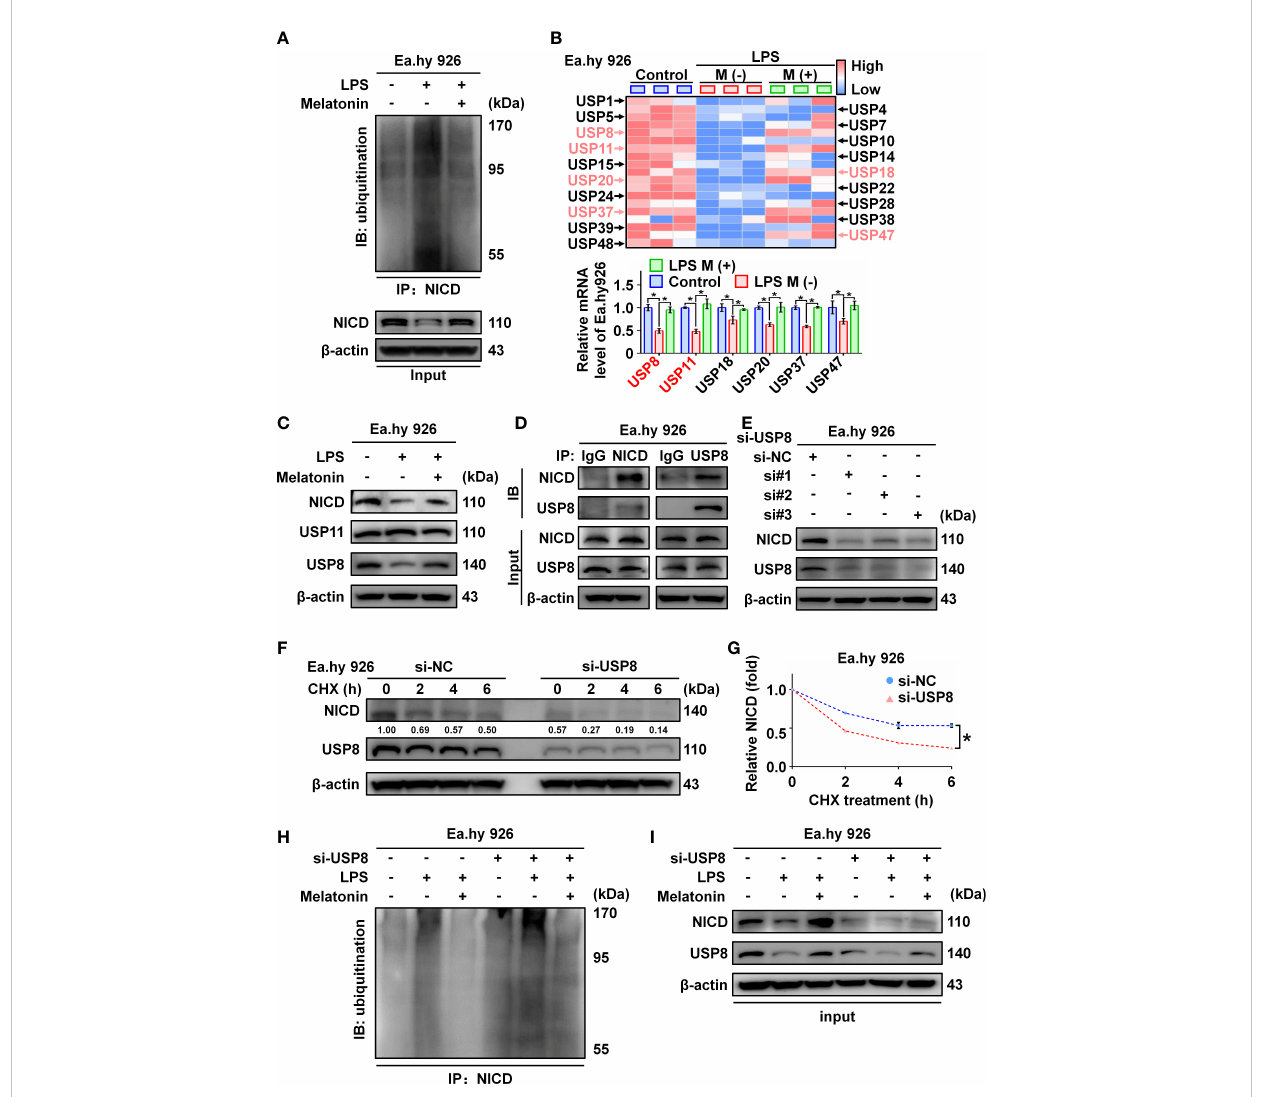
FIGURE 5 The ubiquitination of NICD was regulated by USP8. (A) Ubiquitinated NICD measured by immunoprecipitation with anti-NICD antibody and immunoblotting with anti-ubiquitin antibody in LPS treated Ea.hy 926 cells with or without melatonin. (B) The mRNA expression of a series of DUBs in Ea.hy 926 cells was tested by real-time qPCR. (C) The protein expression of USP8 and USP11 was detected by western blot in LPS-treated Ea.hy 926 cells with or without melatonin. (D) The interaction of NICD and USP8 in Ea.hy 926 cells was detected using Co-immunoprecipitation. (E) The expression of NICD and USP8 in Ea.hy 926 cells transfected with different USP8 siRNA. Scramble siRNA was used as negative control (si-NC). (F, G) The stability of NICD was tested in Ea.hy 926 cells transfected without or with si-USP8 at the indicated time after CHX (20 m M) treatment (F) . The quantitative analysis of (G) with Image J. (H, I) The ubiquitination of NICD in Ea.hy 926 cells with indicated treatment through NICD immunoprecipitation (H) and input (I) . Data are shown as the mean ± SEM. * p < 0.05. ns, no signi fi